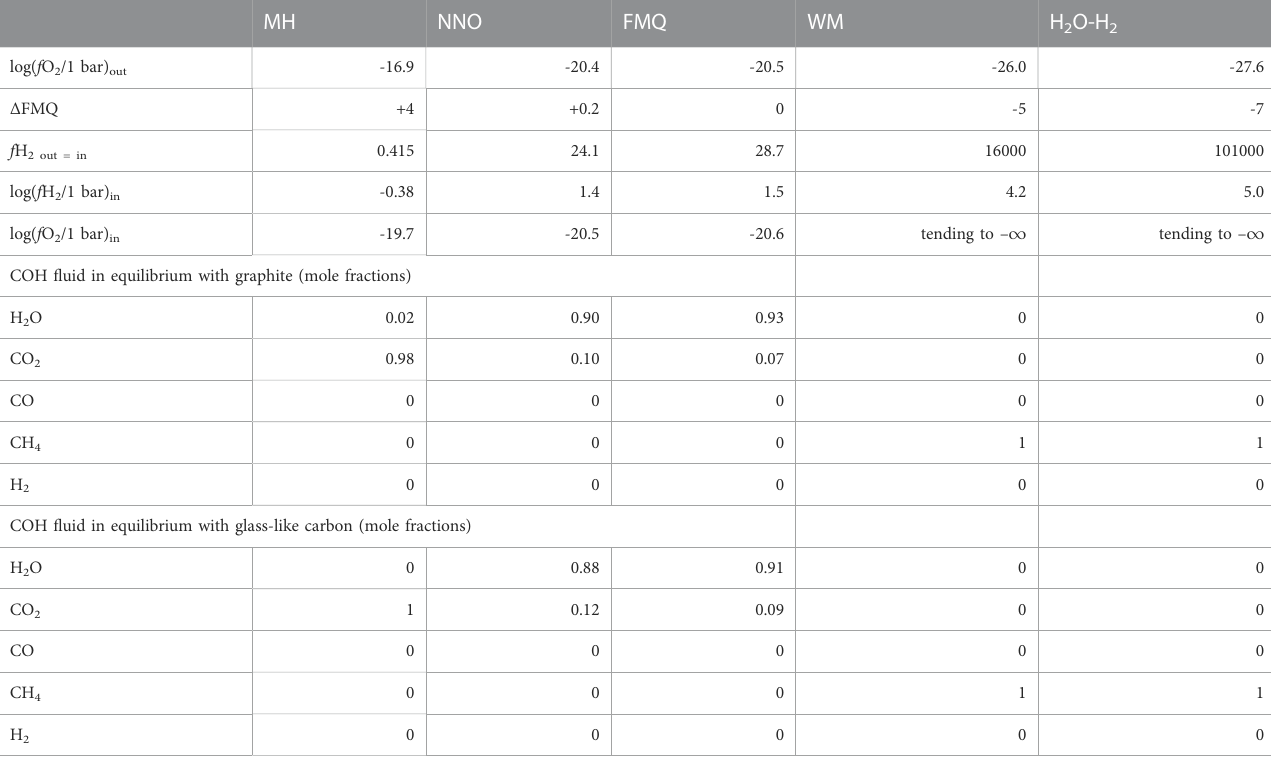
TABLE 1 f O 2 and f H 2 in the external (out) and internal (in) capsule and compositions of COH fl uid in equilibrium with either graphite or glass-like carbon calculated for the indicated buffers at 550 ° C, 1 GPa. See Section 2.2.2 for the details of the